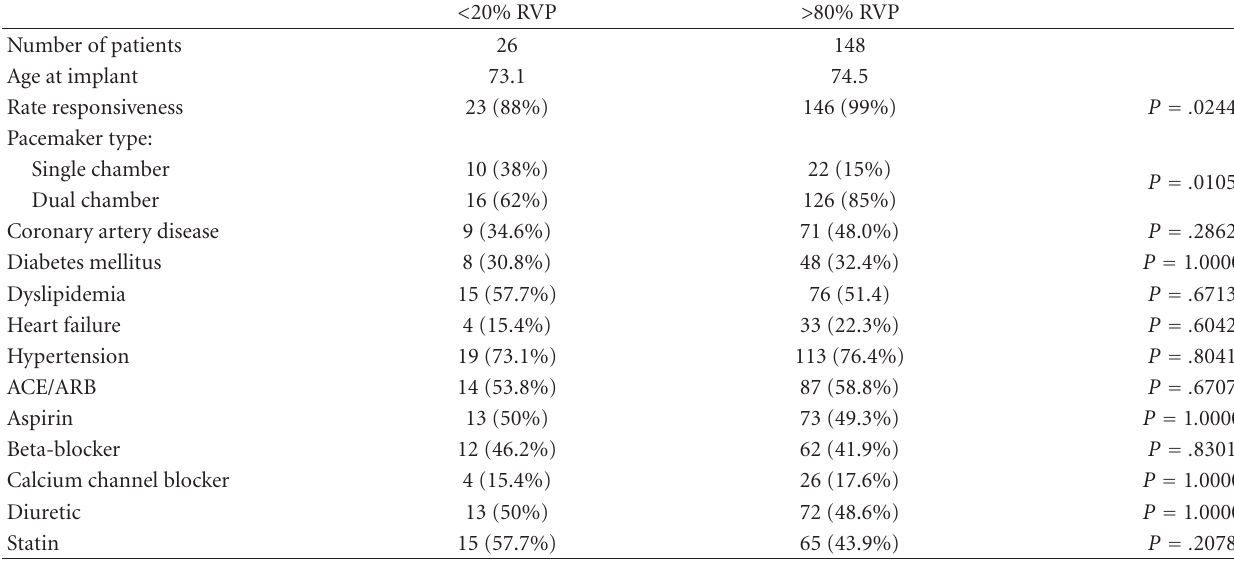
Table 3: Clinical characteristics in Washington, DC VAMC subgroup.